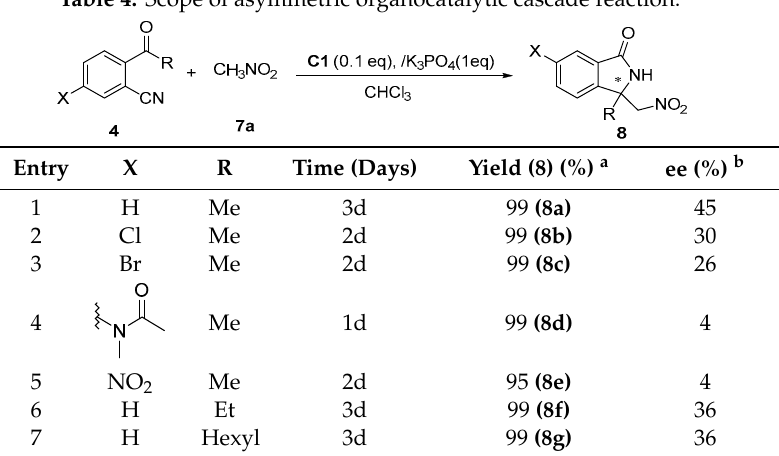
Table 4. Scope of asymmetric organocatalytic cascade reaction.